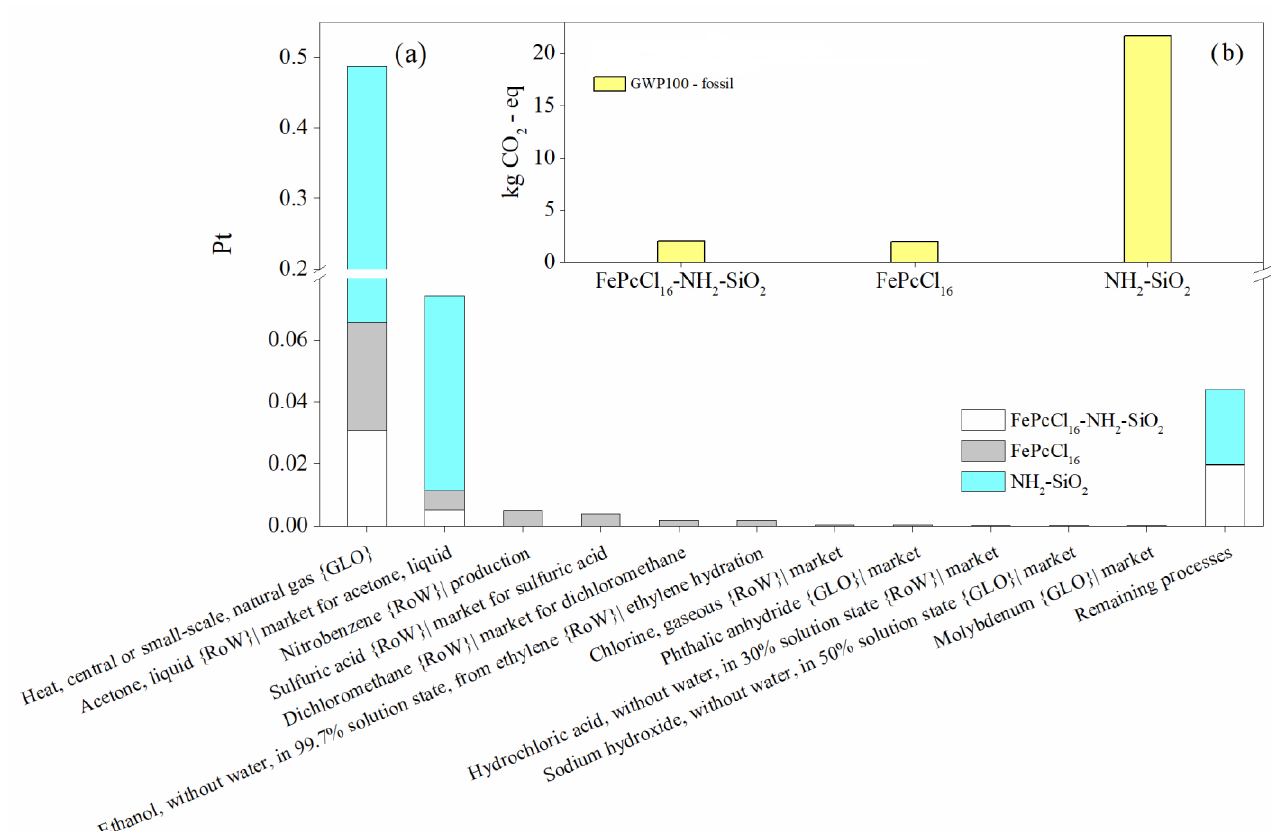
Figure 7. Environmental impact assessment in the production of the catalyst FePcCl 16 -NH 2 -SiO 2 , support and active phase by ( a ) process contribution and ( b ) the global warming potentials. Assessment methods: ReCiPe 2016 Endpoint (H) V1.06/World (2010) H/A; IPCC 2021 GWP100 v1.0.